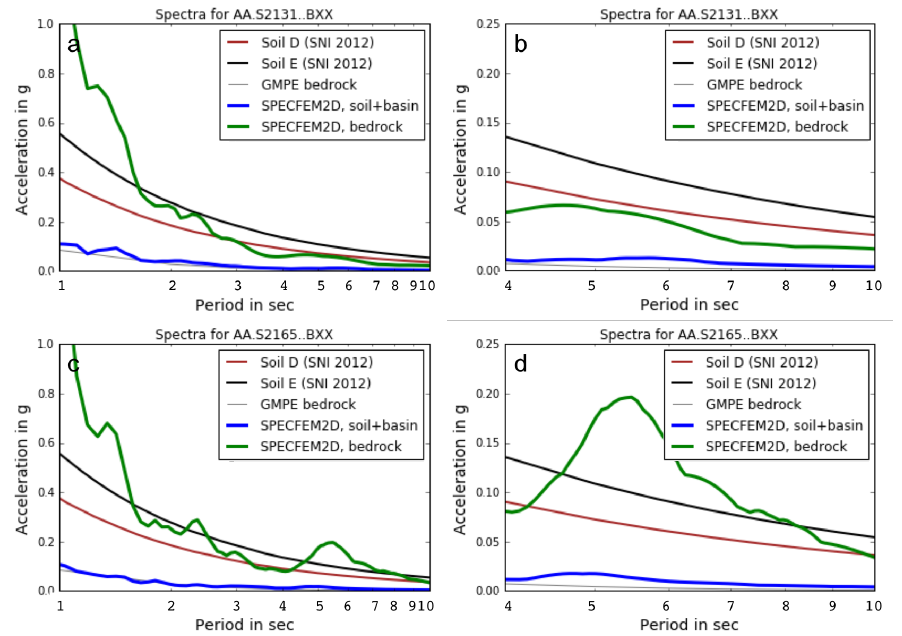
Figure 17. Computed acceleration response spectra for the intraslab earthquake scenario, plotted with the PSA using the AEA2015S GMPE and the Jakarta Building Code’s design response spectra (for D-type soil, thick-black curve) at stations S2131 ( a ) and S2165 ( c ). ( b , d ) are zoomed images of ( a , c ), respectively, for the period band 4–10 s. Locations of S2165 are indicated in Figure 12 5.19 and 5.20, while S2131 is 500 m north of S2130 in the same figures. Note, that the Y-axes have different